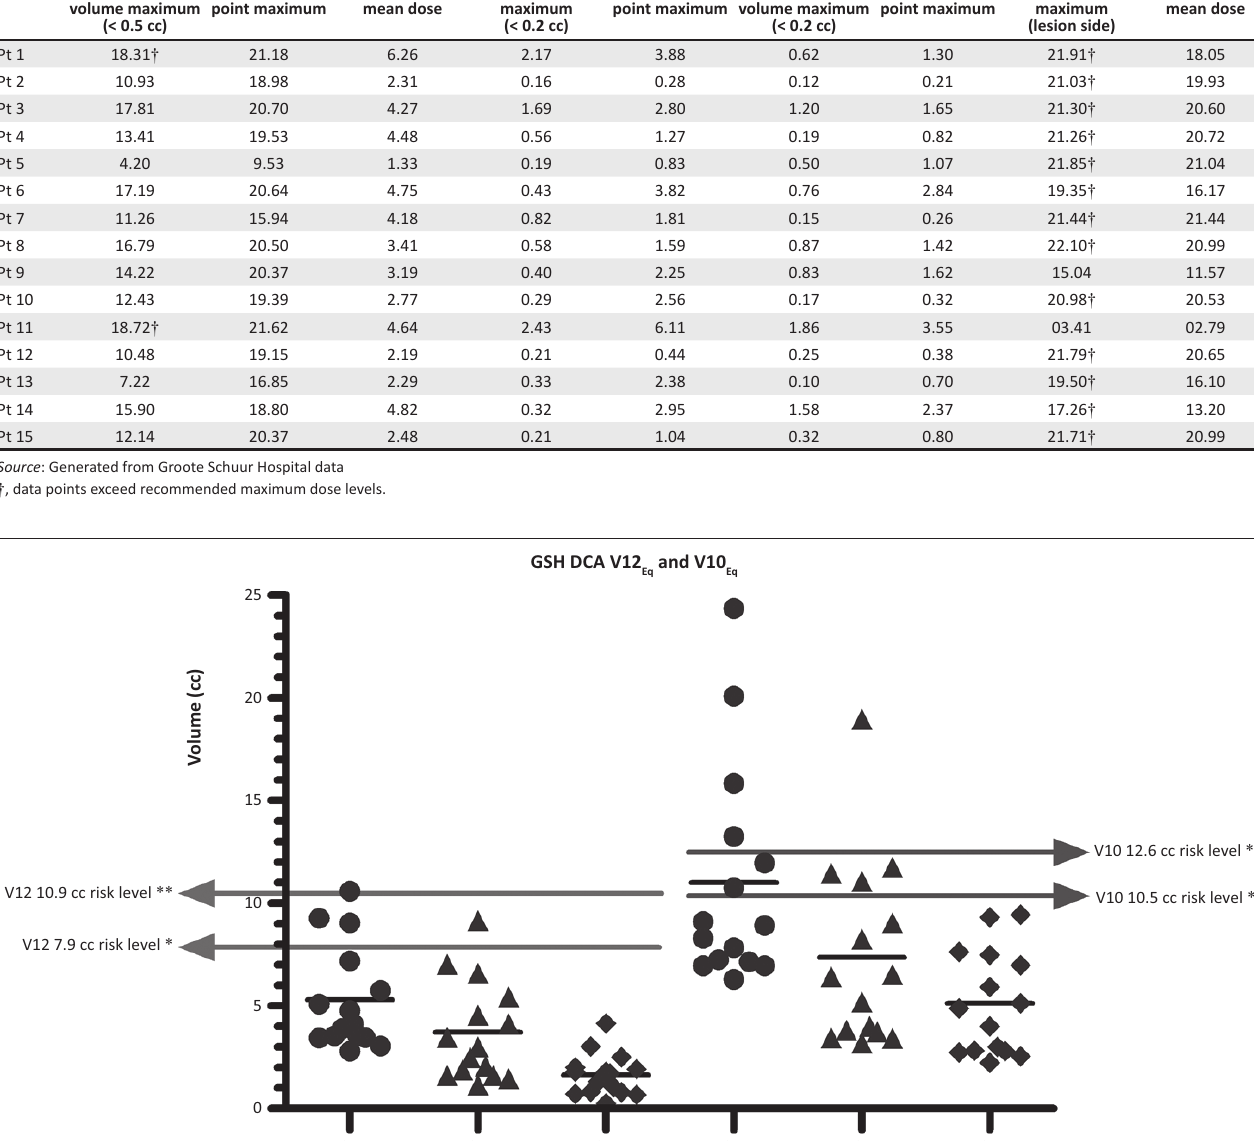
TABLE 1: Critical structure doses for Groote Schuur Hospital dynamic conformal arc technique. Variable Brainstem volume maximum (< 0.5